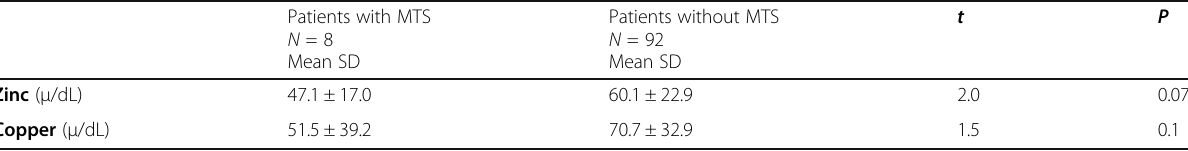
Table 4 Comparison between patients with and without mesial temporal sclerosis in MRI Patients with MTS N = 8